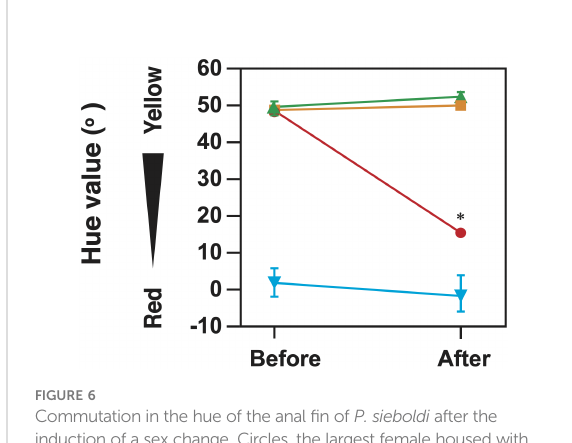
FIGURE 6 Commutation in the hue of the anal fi n of P. sieboldi after the induction of a sex change. Circles, the largest female housed with fi ve smaller females; squares, a larger female with a smaller female; triangles, a female with no other individuals; inverted triangles, a male with a female during the same period as a reference for TP coloration. Sex changes were induced during the pre-spawning season in fi sh placed in 200 L tanks. Each value represents the mean ± SEM of fi ve replicates. Asterisks indicate a signi fi cant difference between the start and end of the experimental period (p < 0.001).